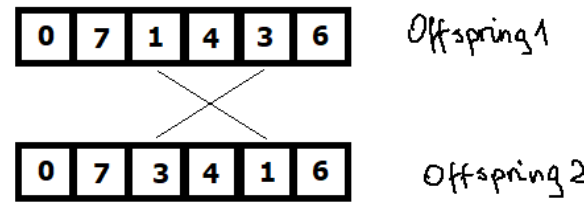
Figure 5. Remove-and-reinsert